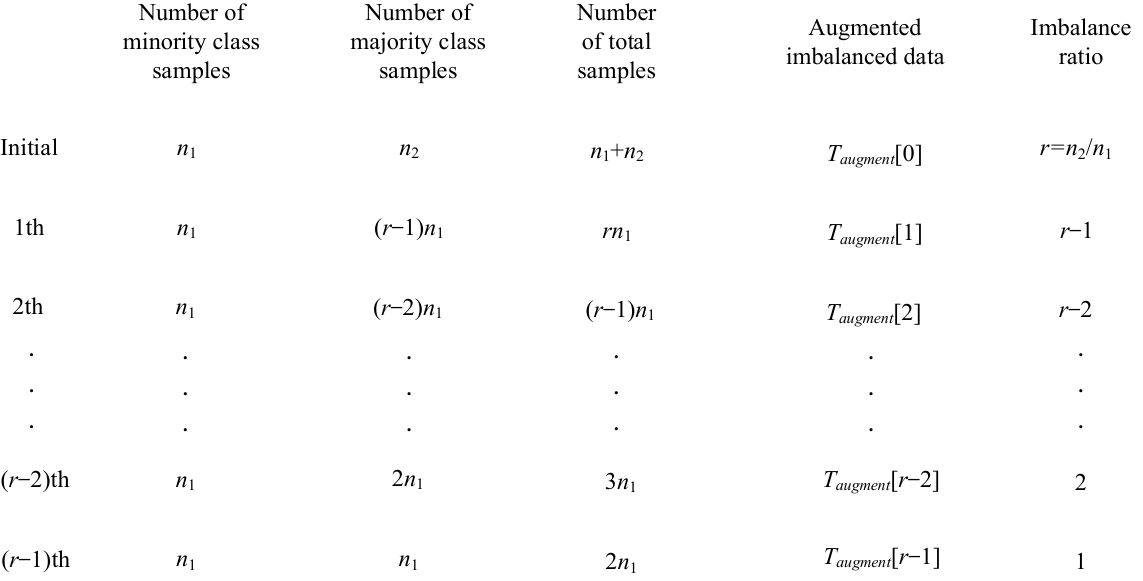
Figure 3. Relationship between the augmentation process and IR change in Algorithm 2. Last, the imbalanced data augmentation algorithm based on the hybrid sampling method is introduced. After applying Algorithm 3, the augmented imbalanced dataset with decreasing IR can be obtained. Algorithm 3 Hybrid sampling based imbalanced data Algorithm 3 Hybrid sampling based imbalanced data augmentation